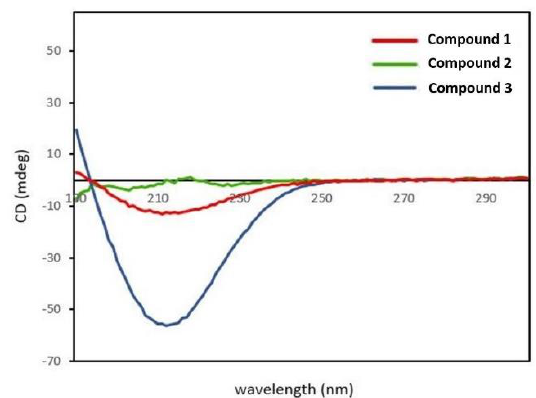
Figure 4. CD spectra of aqueous solutions of compounds 1 – 3 (0.01 wt%).